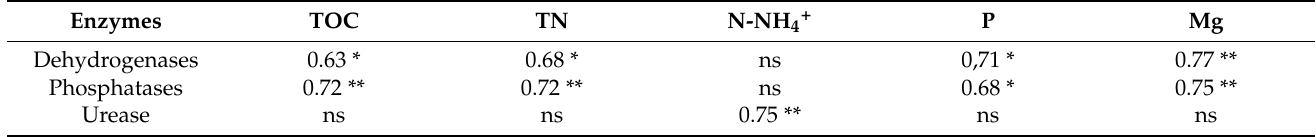
Table 6. Correlation coefficients between the activity of the examined enzymes and content of organic carbon (TOC), total nitrogen (TN) and N-NH 4+ , and assimilable phosphorus (P) and magnesium (Mg) forms, (N = 8).